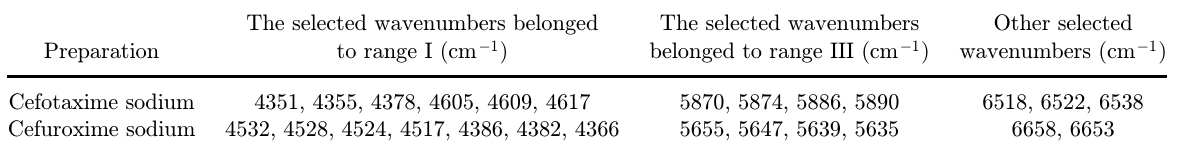
Table 6. Results of CARS analysis for cefotaxime sodium and cefuroxime